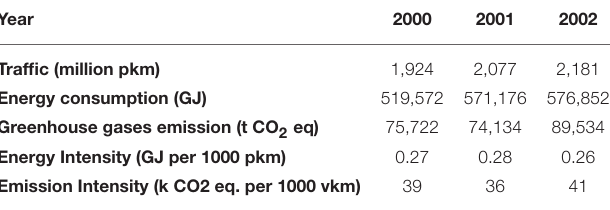
TABLE 10 | Energy and emission of the Madrid-Seville